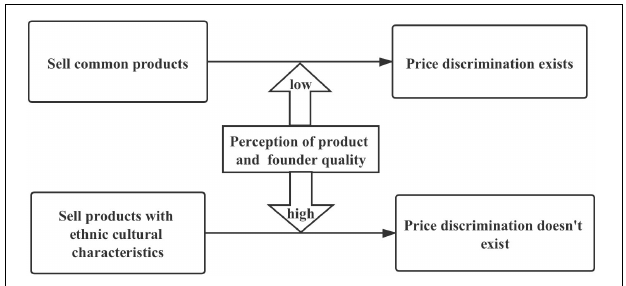
FIGURE 1 | Theoretical process